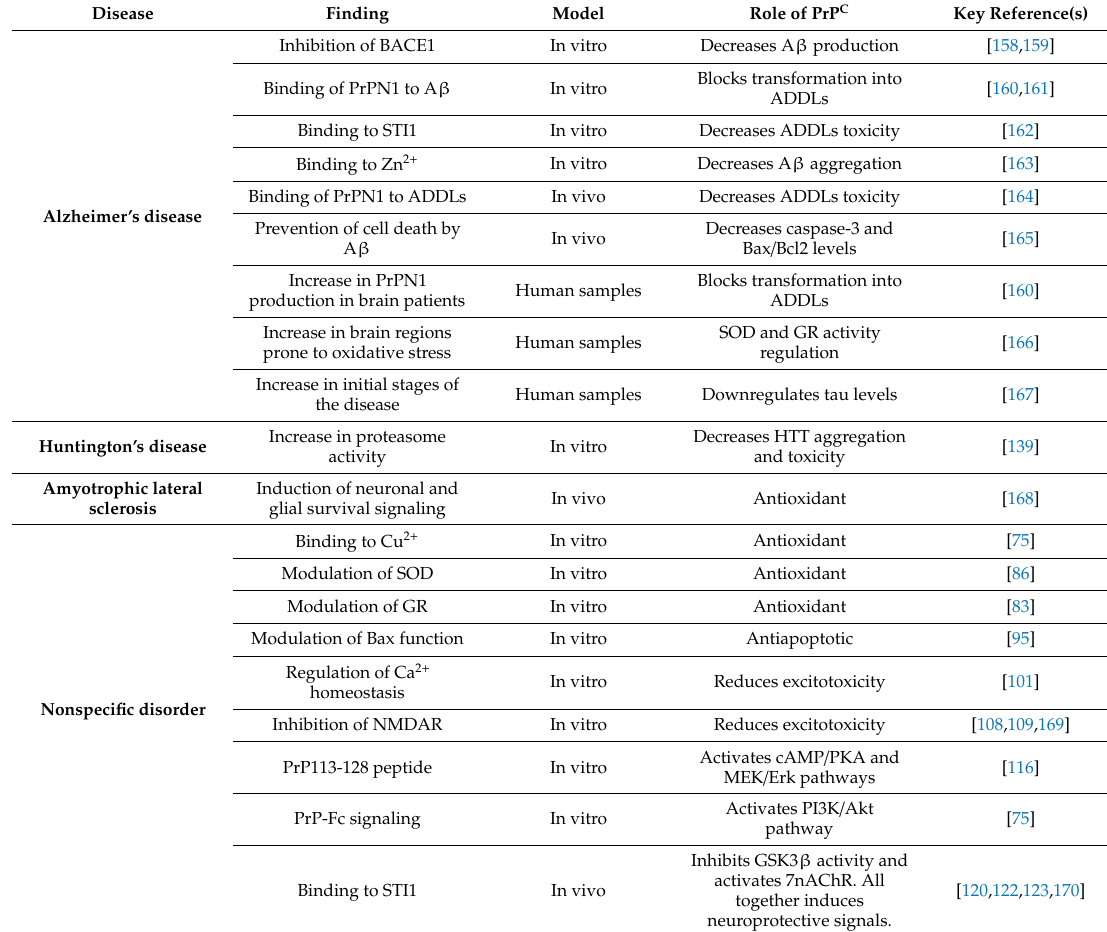
Table 1. Studies on contribution of PrP C to potential neuroprotection in neurodegenerative diseases.